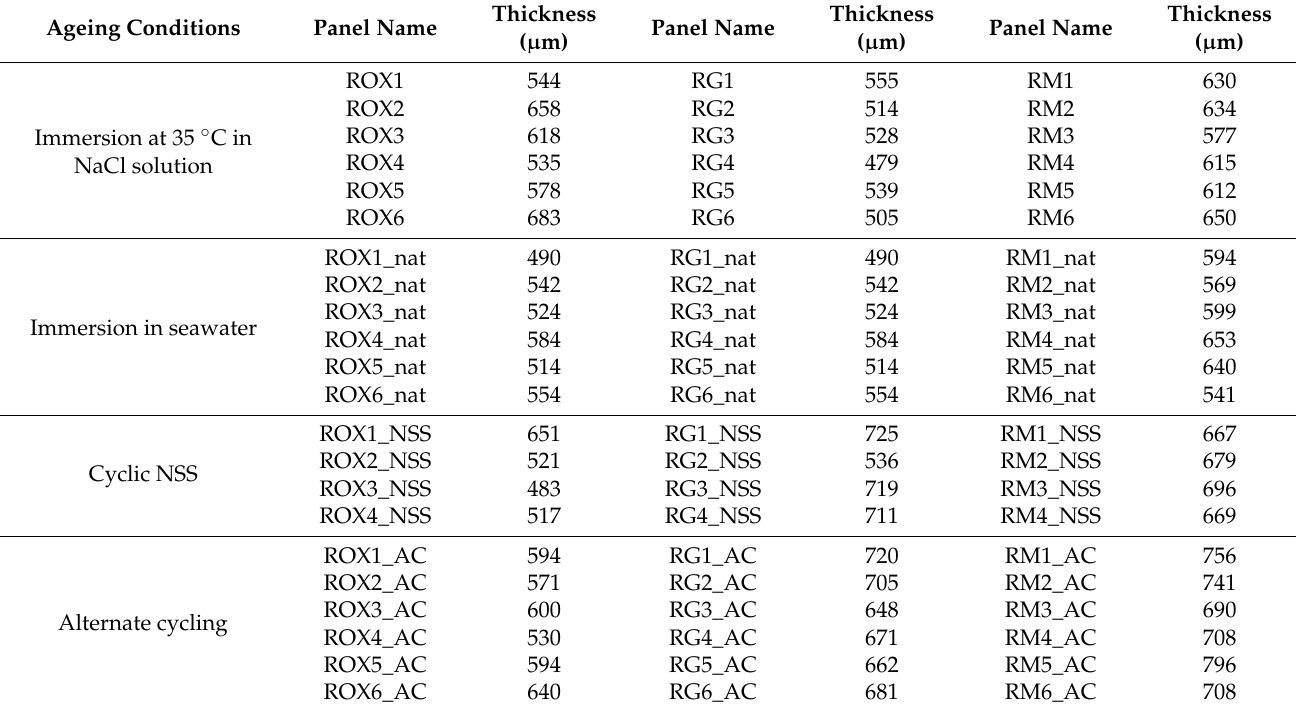
Table 2. Name and measured thickness of the defect-free coated panels tested in the different ageing